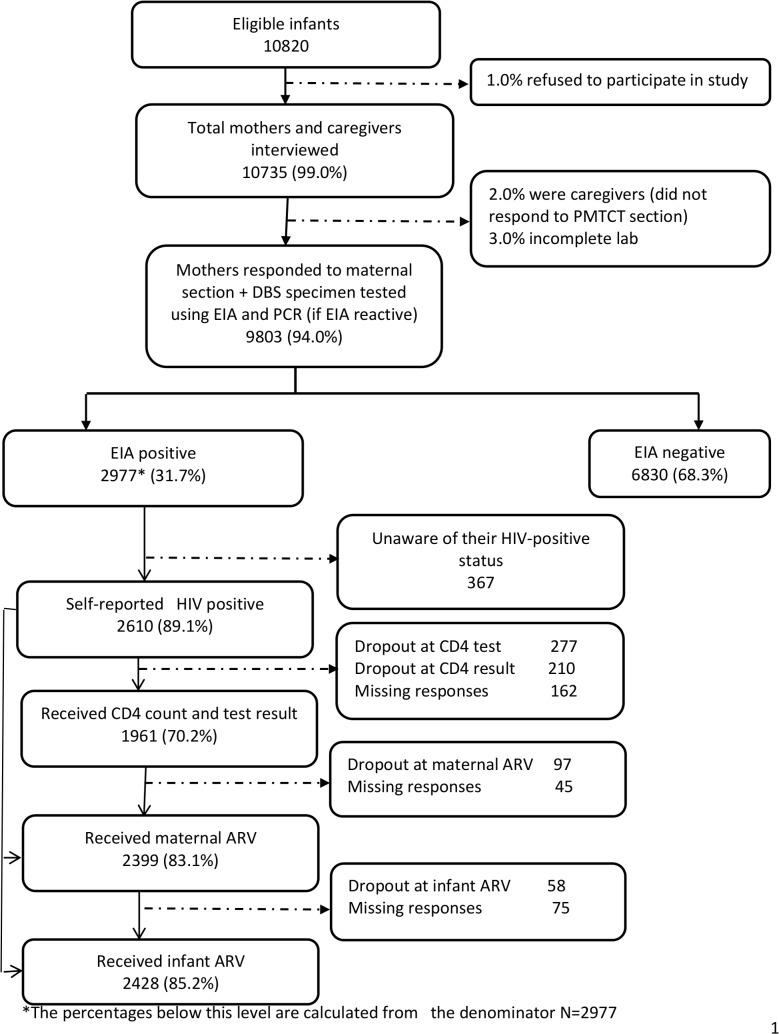
2010 PMTCT cascade Study Profile.